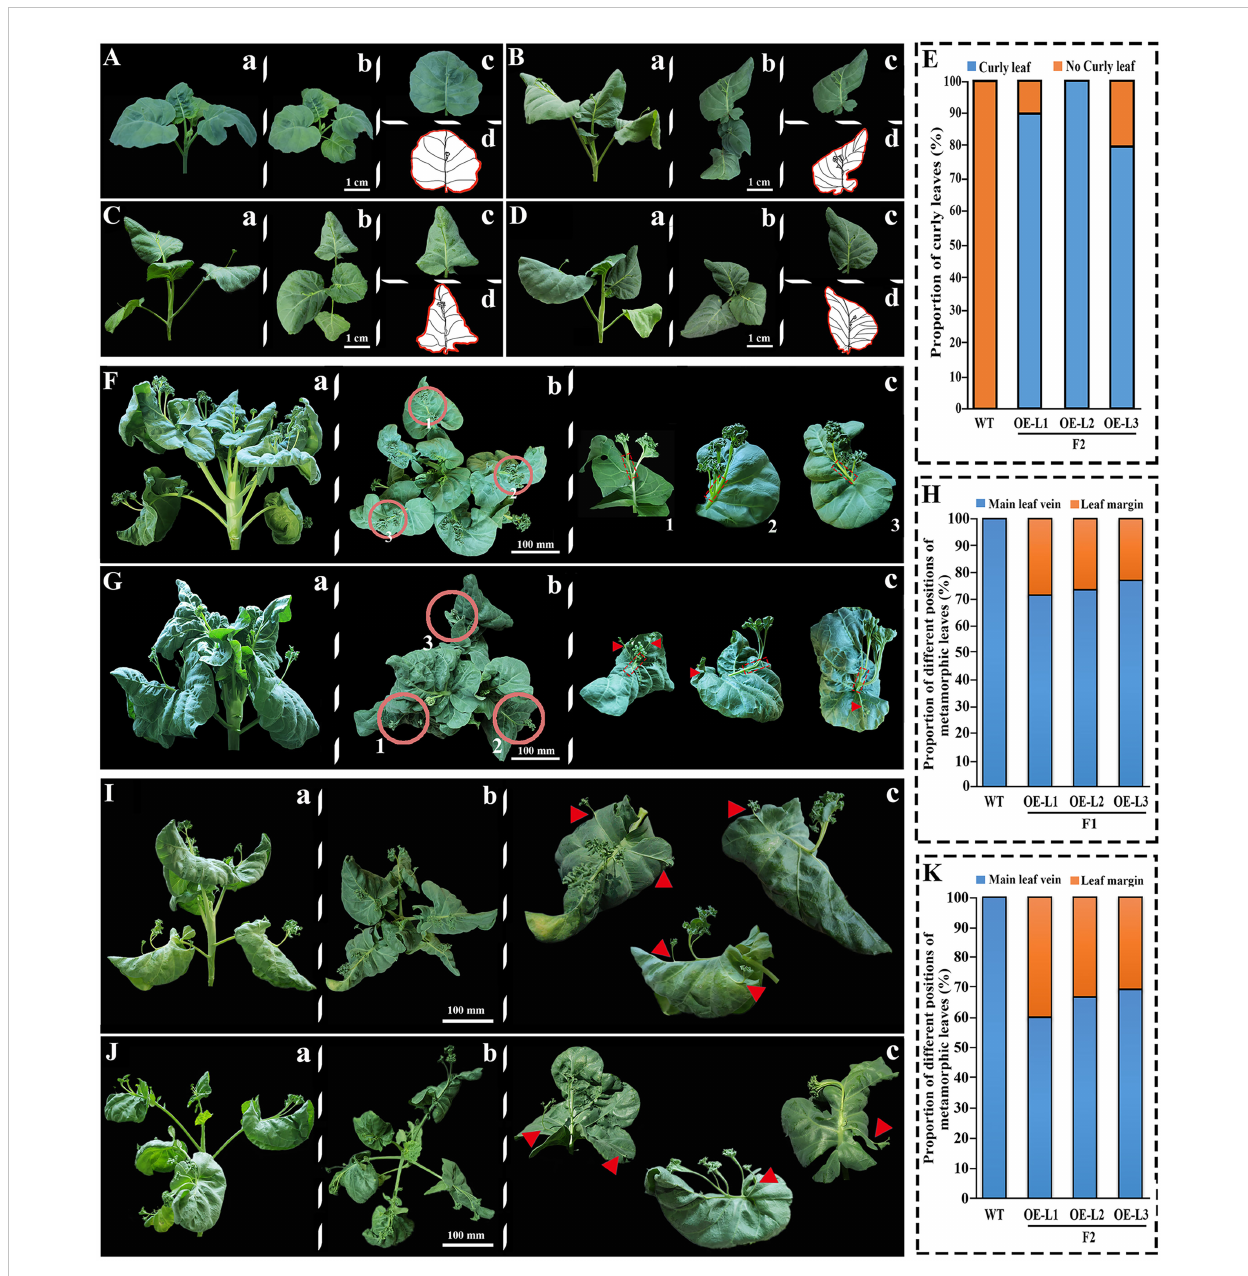
FIGURE 5 Phenotypic analysis of overexpressed BoTCP25-GFP XG plants. The phenotype of leaves of 20-day-old wild-type (A) and three lines of F2 transgenic BoTCP25-GFP XG plants (B-D) . (E) The proportion of curly leaves in the wild type and BoTCP25-GFP overexpressed lines. The metamorphic leaves in the wild-type (F) and F1 BoTCP25-GFP overexpressed Chinese kale plant generation (G) . (H) The proportion of metamorphic leaves on the main leaf vein and margin in the wild-type and BoTCP25-GFP F1 generation transgenic plant. (I-J) Typical metamorphic leaves on the BoTCP25-GFP transgenic plants. (K) The proportion of metamorphic leaves on the main leaf vein and margin in the wild-type and BoTCP25-GFP F2 generation transgenic plant. Lowercase letters a, b, and c refer to the frontal, top, and single-leaf views of each stage. The lowercase letter d is the diagram of a single leaf in (C) The red triangle is the site of the metamorphic leaves. The bars in (A – D) indicate 1 cm, and in (F, G, I) , and (J) 10 cm. DAS, Days After Sowing; DPI, Day Post